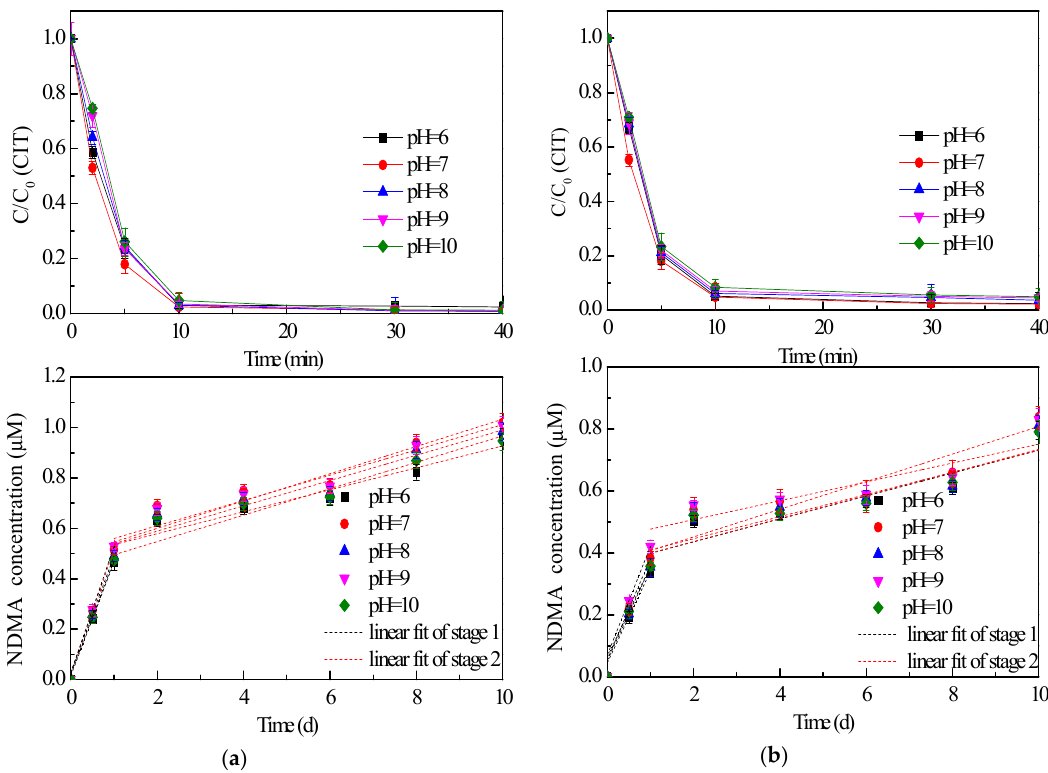
Figure 3. Effect of pH value on CIT removal and NDMA formation (NaOCl ( a ), ClO 2 ( b ), C 0 = 20 µM, [NaOCl] = [ClO 2 ] = 1 mM) (Black dash lines represent linear fit of the first stage of NDMA generation, red dash lines represent linear fit of the second stage of NDMA generation).